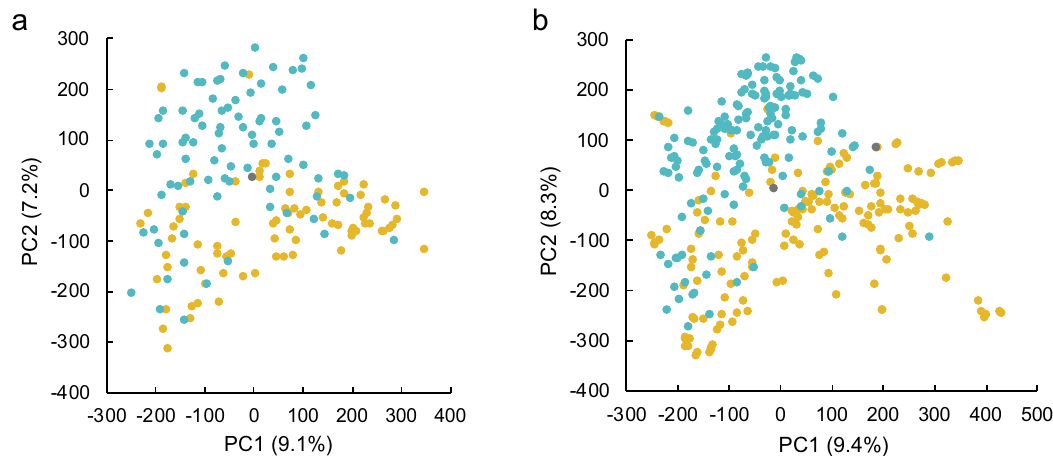
Figure 4. Genetic structure of temperate japonica rice varieties in Japan. Principal component analysis of temperate japonica rice in Japan based on whole-genome sequence data, with the x-axis representing the PC1 and the y-axis representing the PC2: ( a ) 2018; ( b ) 2019. Values in parentheses indicate the percentage contribution of each principal component. The yellow, blue and black markers indicate landraces, breeding varieties and unidentified varieties, respectively. Principal component analysis was performed using the package ‘pcaMethods’ 67 for R software (https:// www.R- proje ct. org/) 65 .